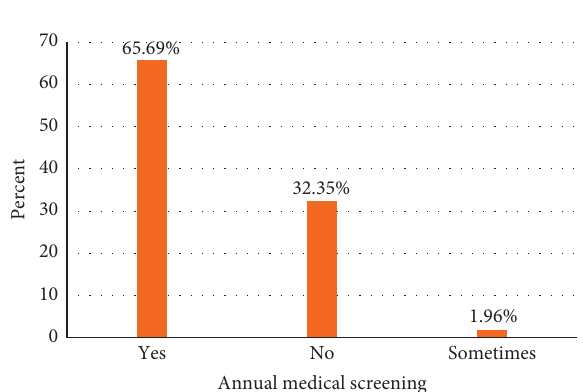
Figure 3: Annual food vendor medical